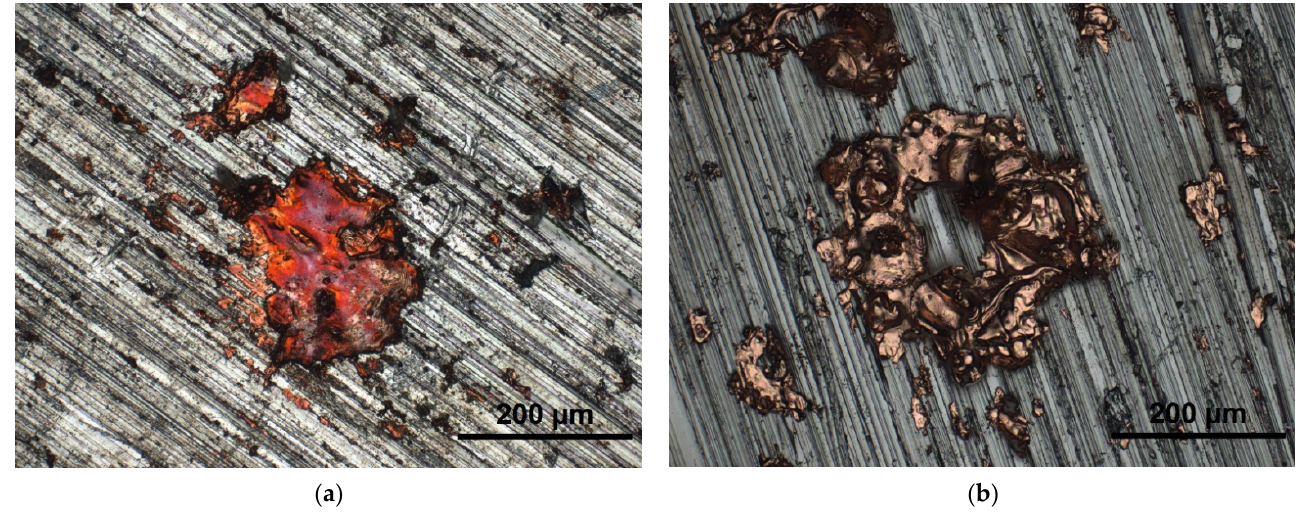
Figure 12. Optical micrographs revealing the shape of the splats formed on the substrate surface in different environments: ( a ) copper splats formed in air; and ( b ) copper splats formed in silane- doped nitrogen.